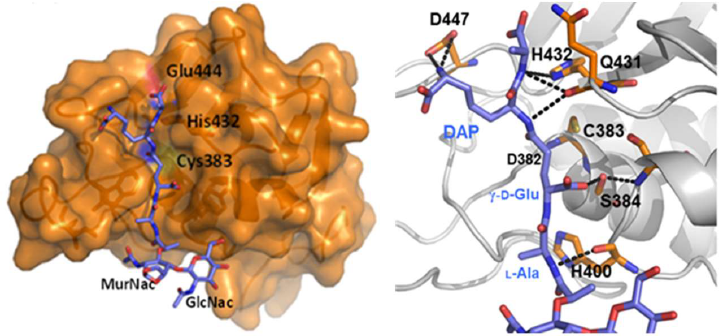
Figure 5. Modeling of a PGN monomer in the catalytic site cleft of RipA (left) and main interactions of the PGN monomer with the enzyme [49] .